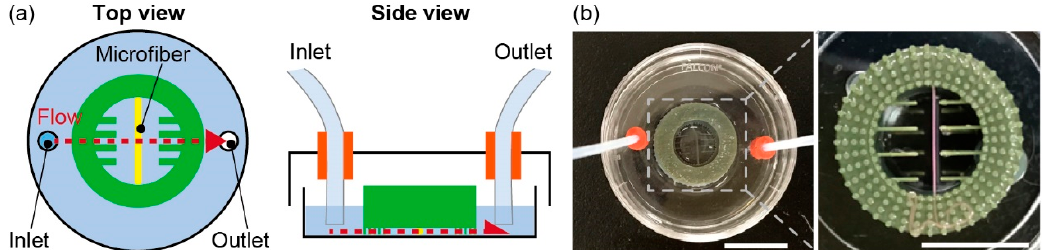
Figure 4. Experimental setup to evaluate immobilization of the microfiber in the anchoring device: ( a ) Conceptual illustration of applying flow to the microfiber in the device; ( b ) Image of the experimental setup. Scale bars are 10 mm.